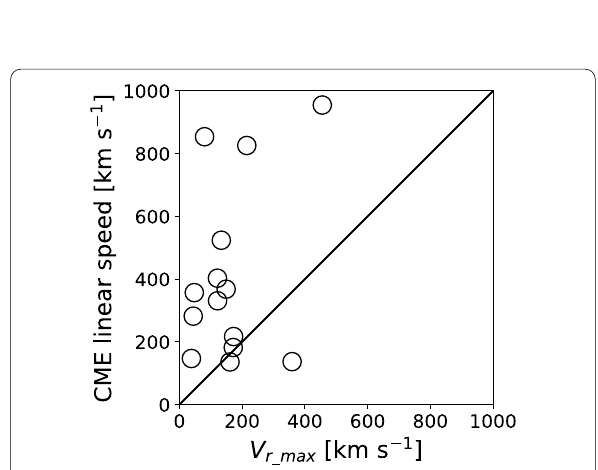
Fig. 5 Plot of filament eruptions according to V r_max and CME linear speed. The black line corresponds to equal